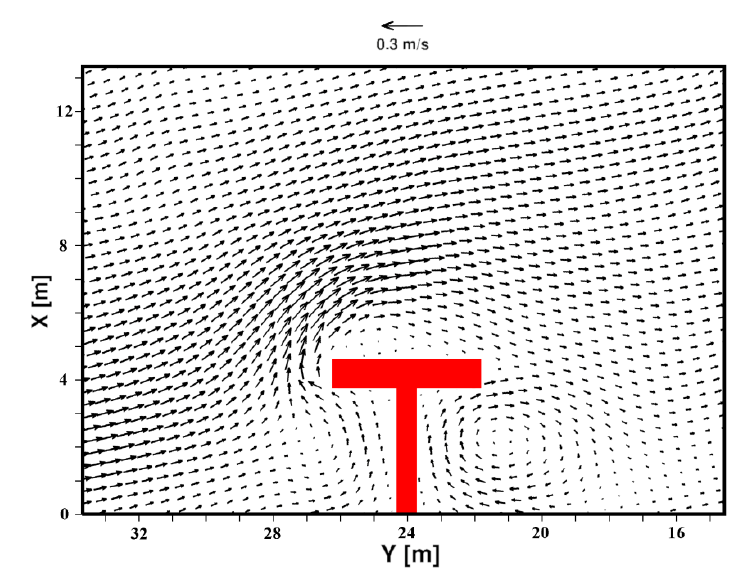
Figure 7. Plan view of the time-averaged velocity field. At a relative position from the free surface z / z b = 0.5.